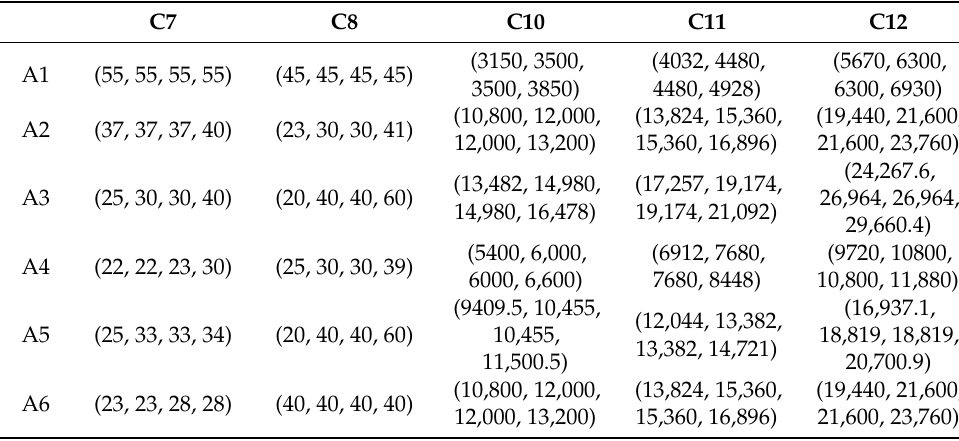
Table 6. Assessments of alternatives common for experts E 1 – E 3 .